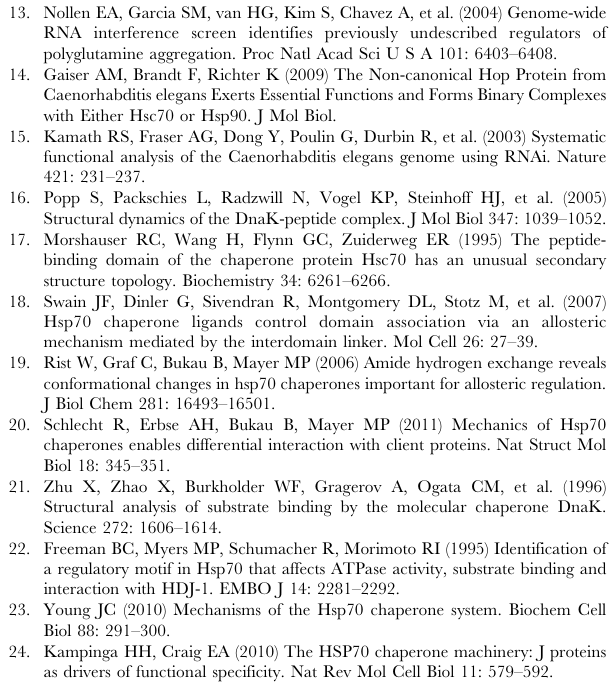
Figure S1 Thermal stability of CeHsc70 versus HsHsc70. DSF melting curves indicate that Hsc70 from C. elegans ( % ) is about 10 u C less stable than the human ortholog ( # ). Adding ADP stabilized CeHsc70 ( & ) as well as human Hsc70 ( N ) to a similar extent. Error bars reflect the standard deviation of three experiments. Figure S2 The influence of a His 6 tag on ATPase activity. His 6 -CeHsc70 as used throughout the study and as described in the Materials and Methods section was compared to a His 6 free protein batch, generated from the same stock. The removal of the tag increases the average activity within the margin of error (standard deviation of three measurements). Figure S3 Comparative stabiliy of CeHsc70